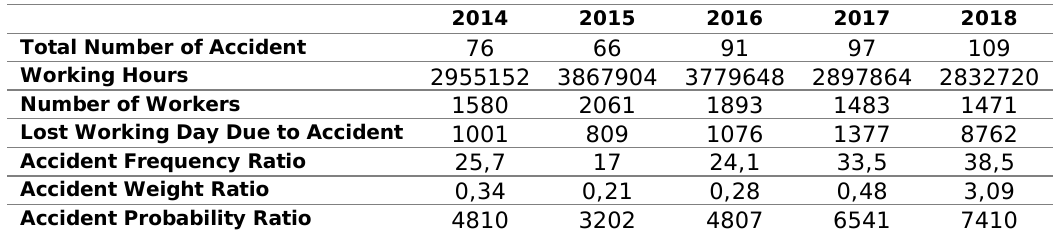
Table 2. Calculated Accident Ratios for the Years 2014 and